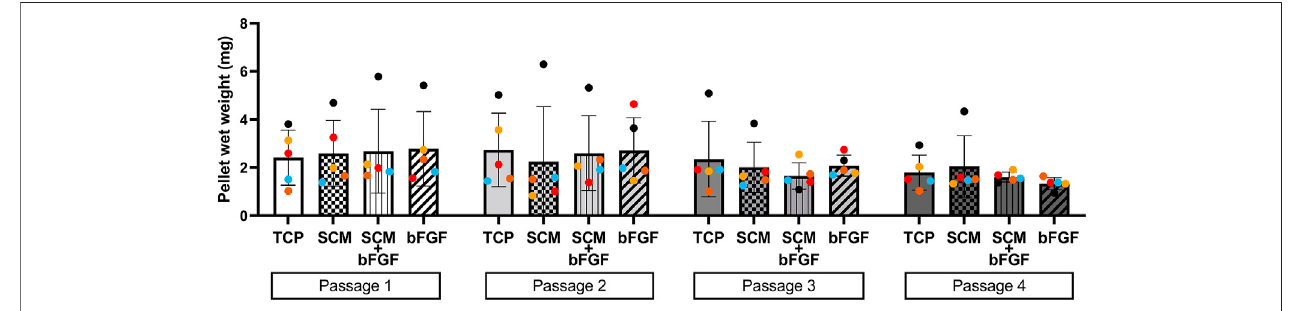
FIGURE 3 | Human cartilage aggregate wet weight. Cartilage aggregates from fi ve donors (average aggregate weight, ≥ three aggregates per donor, each color representsadonor) forfourpassageson tissue cultureplastic(TCP),synoviocyte-derived extracellularmatrix(SCM),on synoviocyte matrixwith bFGF (SCM+bFGF), or on tissue culture plastic with bFGF (bFGF). p < 0.05 are shown, two-way ANOVA (no signi fi cant differences found).